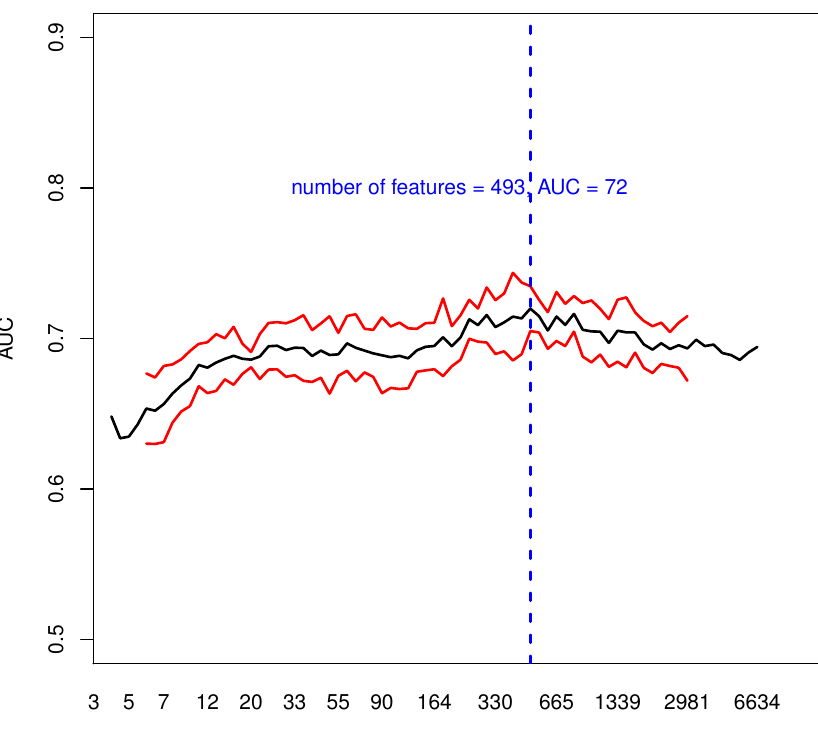
Figure 3. In black, the median AUC over 20 runs of 10-fold cross validation; in red, the median AUC ± its mean absolute deviation; in blue, the number of features (genes) where the maximum median AUC (72%) was reached. For each run, we collected the AUC values obtained at different thresholds C (or equivalently a different number of genes) and we interpolated these values to build a curve. Then we obtained the black curve as the median of 20 curves, one for each 10-fold Cross-Validation (CV) run.